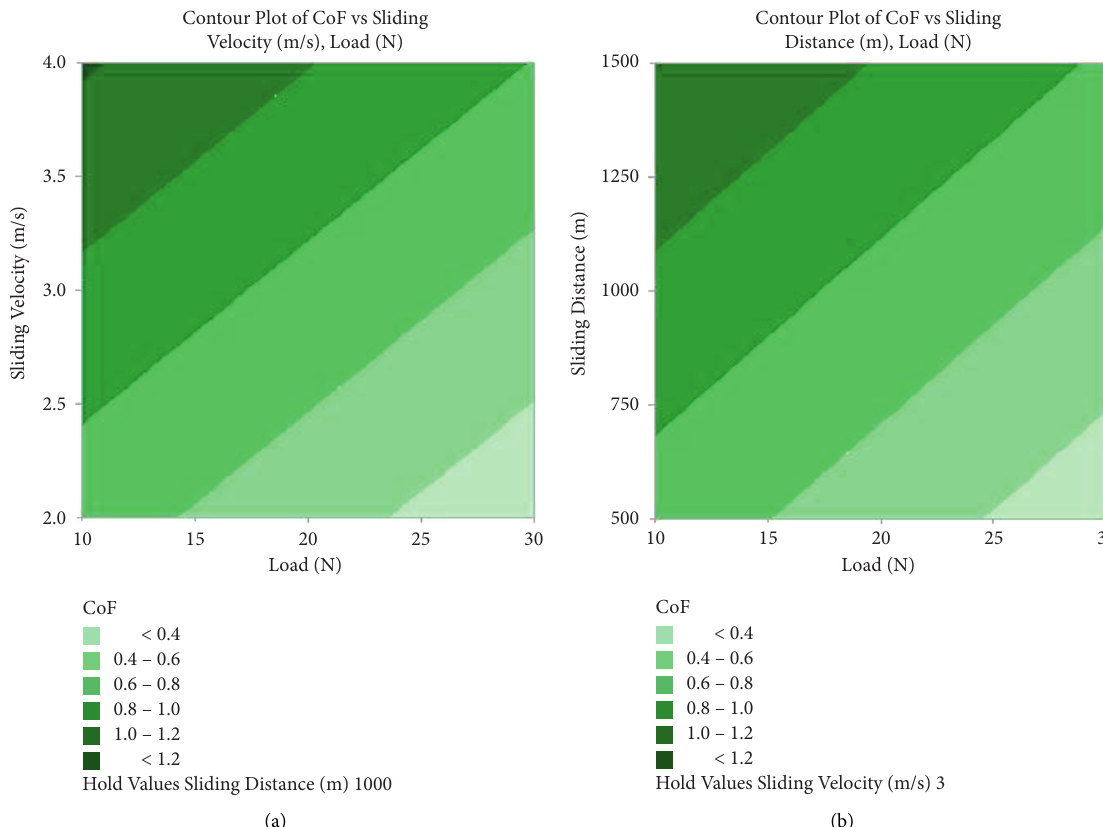
Figure 9: CoF (contour plot). (a) Load vs. sliding velocity. (b) Load vs. sliding